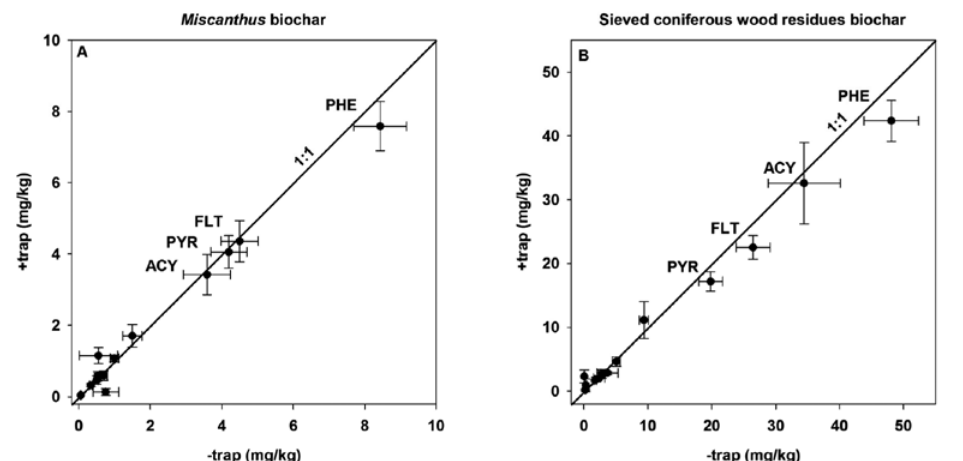
Fig. 2. Scatter plots of remaining PAH contents of two biochars (panel A and B) after their incubation in either contaminant traps (+trap) or similar controls without the infinite sink (–trap). Error bars indicate the standard deviation of duplicates and fall within the symbol if not visible. Individual PAH that showed the highest concentrations are phenanthrene (PHE), fluoranthene (FLT), acenaphthylene (ACY), and pyrene (PYR). (source: Mayer et al. (2016) modified. “This is an unofficial adaptation of an article that appeared in an ACS publication. ACS has not endorsed the content of this adaptation or the context of its